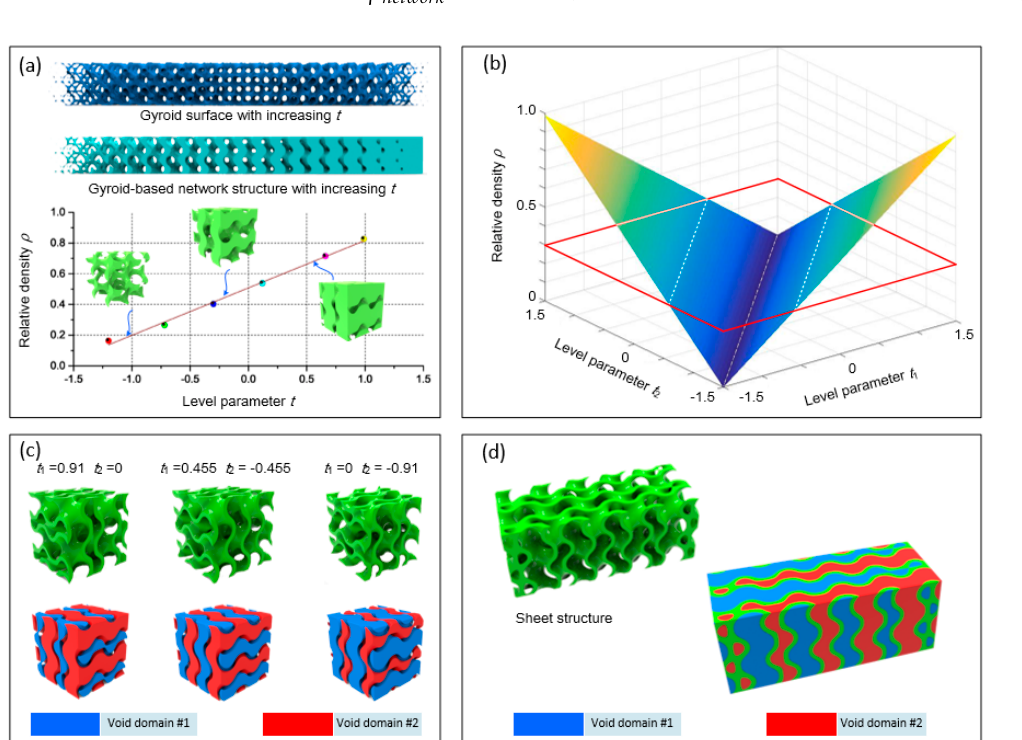
Figure 2. ( a ) Effects on the RD of level parameter in network-based structure; ( b ) relationship between RD and level parameters in sheet-based structure; ( c ) sheet structure with same RD constructed by different groups of level parameters; and ( d ) sheet structure with constant RD by grading level parameters.